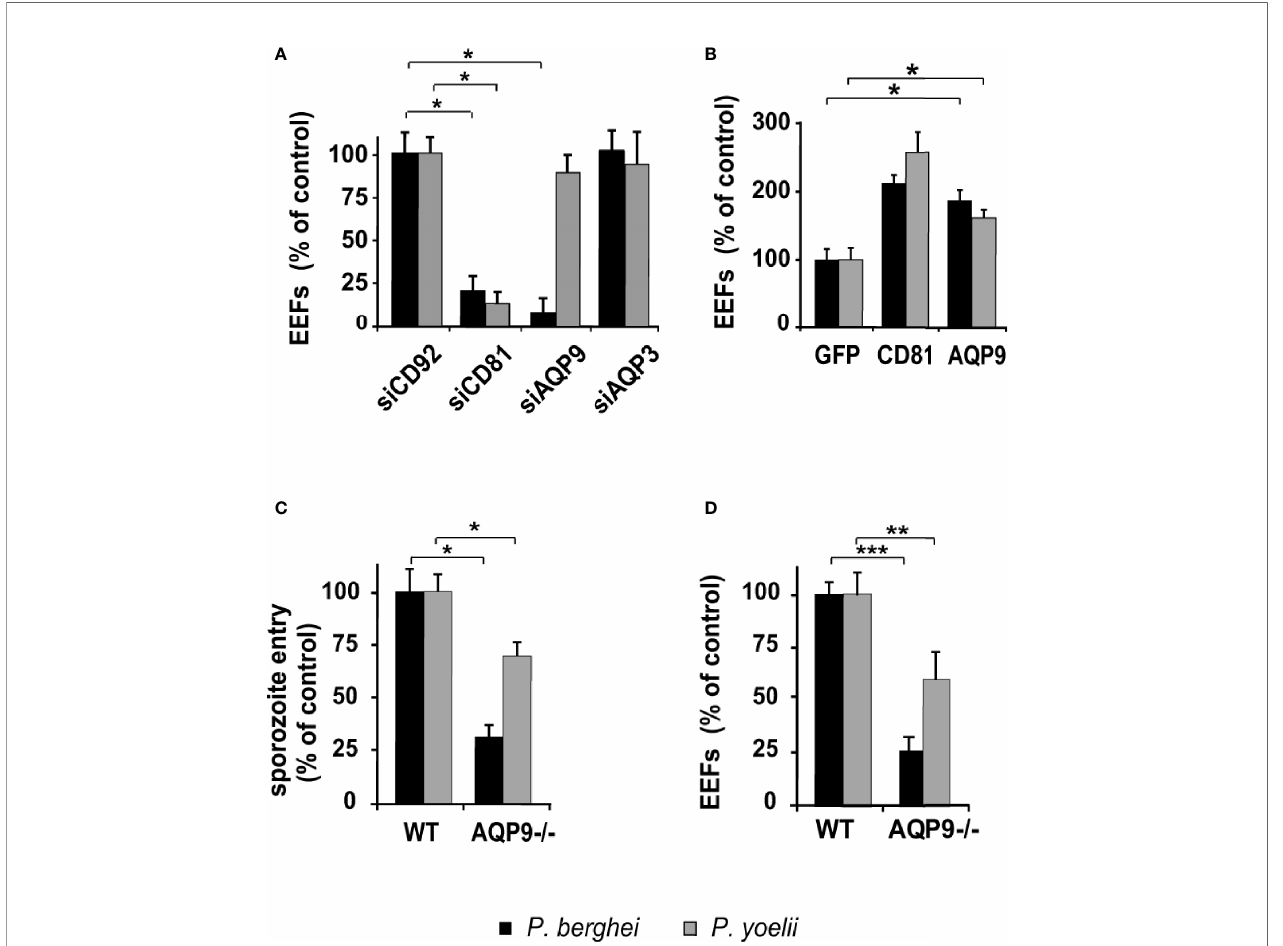
FIGURE 3 | Hepatocyte permissiveness to rodent parasites differentially depends on AQP9 according to parasite/host cell combinations. (A) sihRNA-transfected human hepatocytes (HHs) were infected with sporozoites three days post-transfection and cultured for two days until EEF quanti fi cation. EEF values are expressed as a percentage of those in control sihCD92-transfected hepatocytes. * p = 0.0001. (B) Three days post lentiviral transduction, HHs overexpressing GFP protein, hCD81, or hAQP9 were cultured for two days until EEF quanti fi cation. EEF numbers are expressed as a percentage of those in control GFP-transduced hepatocytes. * p = 0.0079. (C, D) Primary hepatocytes isolated from wild-type (WT) and AQP9 knockout (AQP9-/-) mice were infected with P. berghei or P. yoelii . Sporozoite cell entry was evaluated 3 h post-infection using double immunostaining (C) , whereas EEF quanti fi cation was performed after 48 h of culture (D) . Penetration rates and EEF numbers are expressed as a percentage of those in control WT hepatocytes. * p = 0.05; ** p = 0.0018; *** p = 0.0004. The results are expressed as the mean ± standard deviation. p values were determined by Mann-Whitney U